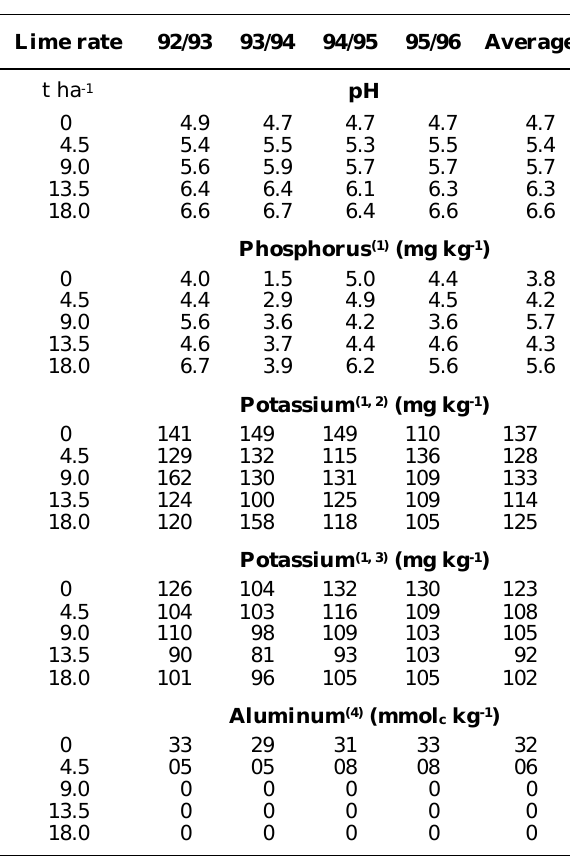
Table 1. Values of soil pH, P, K, and exchangeable Al in the soil samples collected in plots with grain corn after each corn growing season, as affected by addition of increasing rates of dolomitic limestone in an acid Oxisol, in Lages, Southern Brazil. Average of four replicates